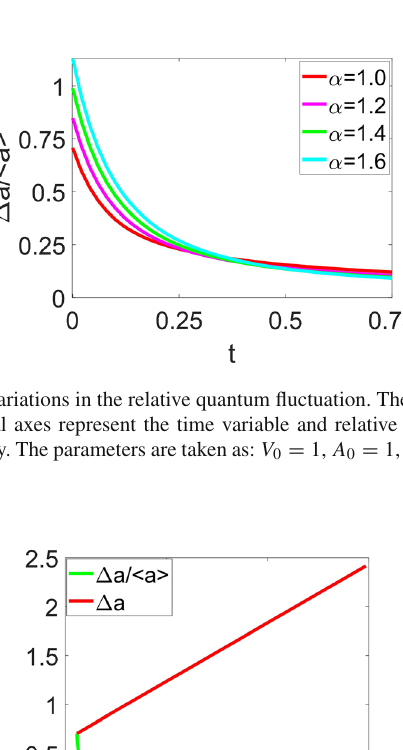
Fig. 24 Variations in the coherence versus the average value of the scale factor (cid:7) a (cid:2) . The parameters are taken as: V 0 = 1, A 0 = 1, mN m = 10